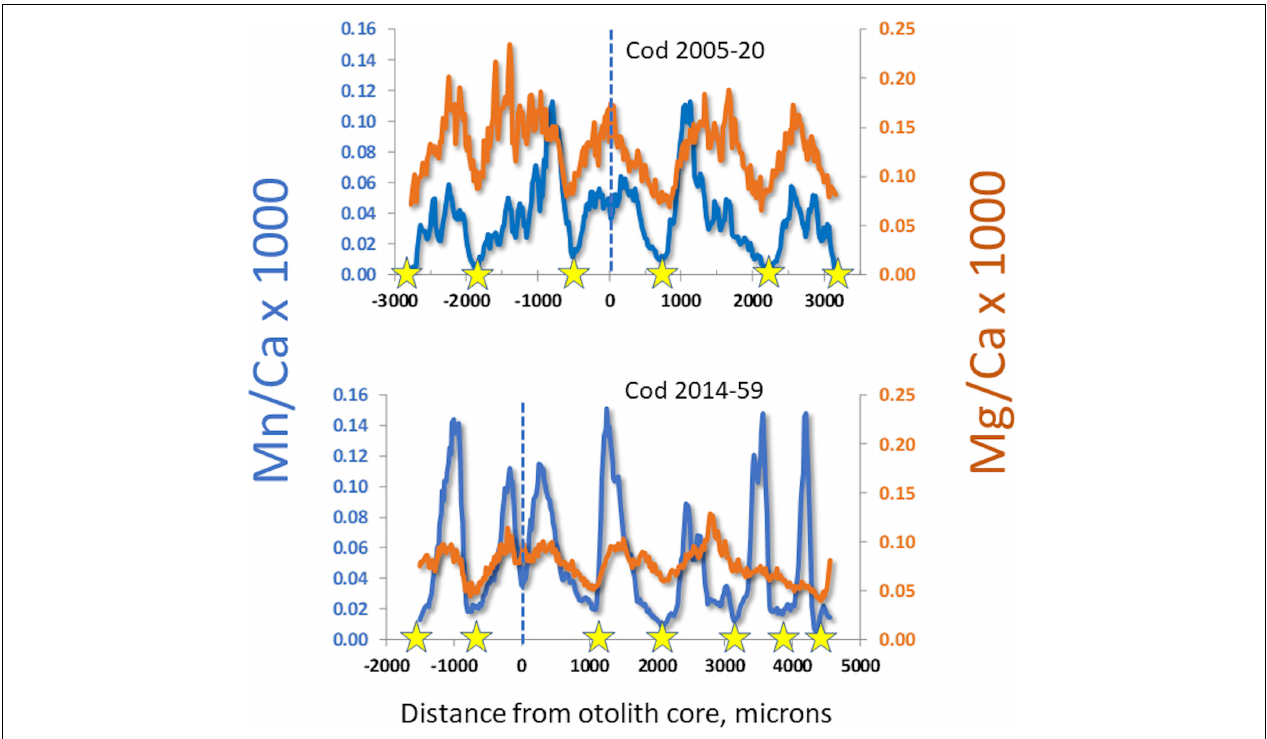
FIGURE 4 | Comparison of manganese and magnesium dynamics in otoliths from cod having experienced different lifetime hypoxia levels. Stars mark winters, dashed lines mark the otolith cores. Top: edge-to-edge otolith transect in a period with good oxygen conditions, with seasonal variations of Mn/Ca and Mg/Ca in synchrony. Bottom: partial otolith transect in a cod having experienced chronic seasonal hypoxia; note that Mn/Ca is higher and Mg/Ca lower than in top panel, and that magnesium begins to de-couple from seasonal patterns in third